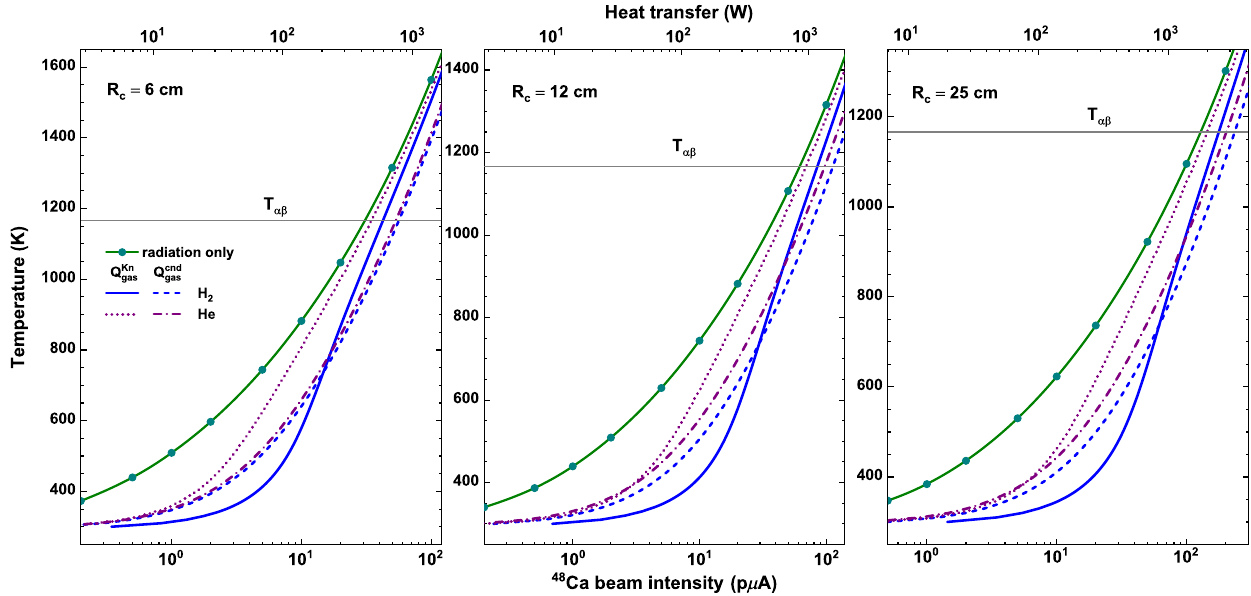
FIG. 17. The same as in Fig. 7, but for the rotating targets with central radii R c ¼ 6 , 12, and 25